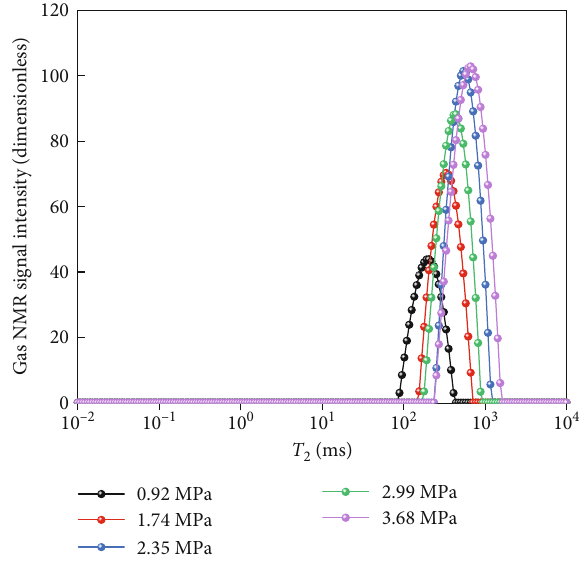
ff erent in fl ation 2 spectra at di